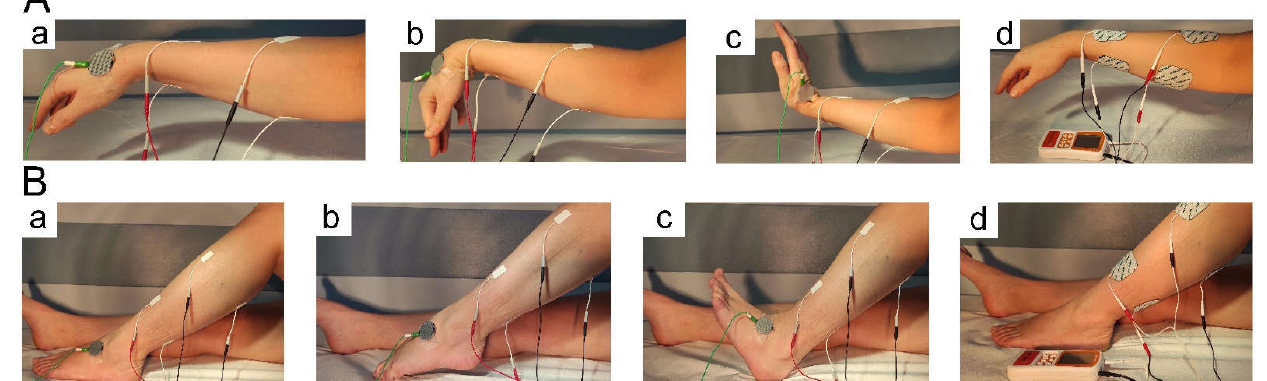
Figure 4. Placement of sEMG recording electrodes over the skin of the muscles acting antagonisti- cally on the wrist ( Aa – c ) and the ankle ( Ba – c ). The position of NMFES stimulating electrodes ( Ad , Bd ) was the same; the active electrode was placed on the muscle belly, while the reference electrode was on the distal muscle tendon, covering the location of the motor points: ( a ), neutral position of the muscles at rest; ( b ), recordings during contractions of flexors; and ( c ), recordings during con- traction of extensors.